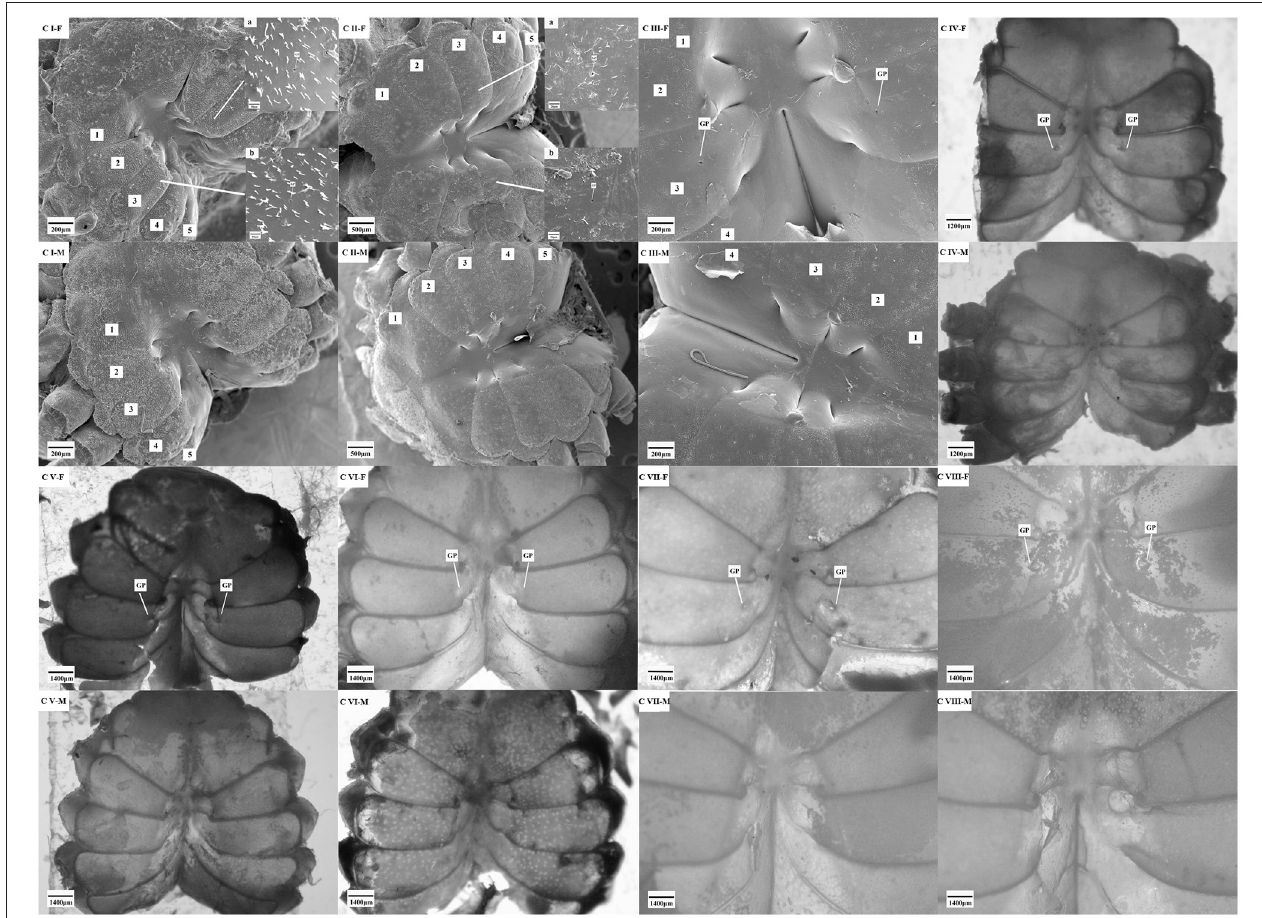
FIGURE 6 | The gonopore characteristics of the S. paramamosain crablets. F, female; M, male; GP, gonopores. C I, C II, C III, C IV, C V, C VI, C VII, and C VIII represent crablets of stages I, II, III, IV, V, VI, VII, and VIII. 1–5, first–fifth thoracic